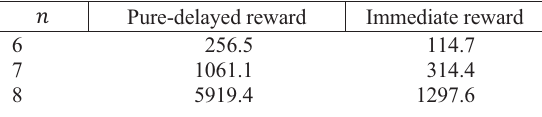
Table 4. The number of training iterations for two reward schemes when 𝑛 equals